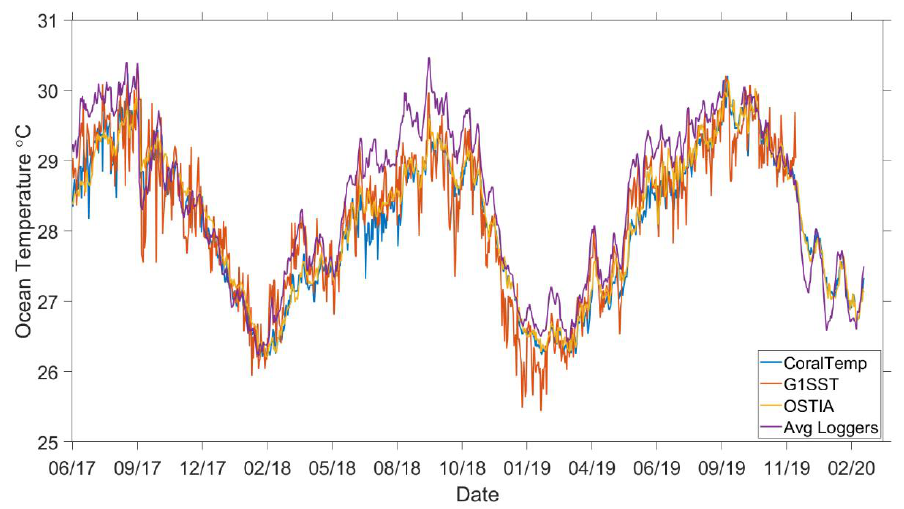
Figure 2. Time series of temperature data from 30 June 2017–1 March 2020 of the three remote sensing datasets (CoralTemp, G1SST, OSTIA) and the averaged in situ loggers for Cayo Enrique and Cayo Mario.